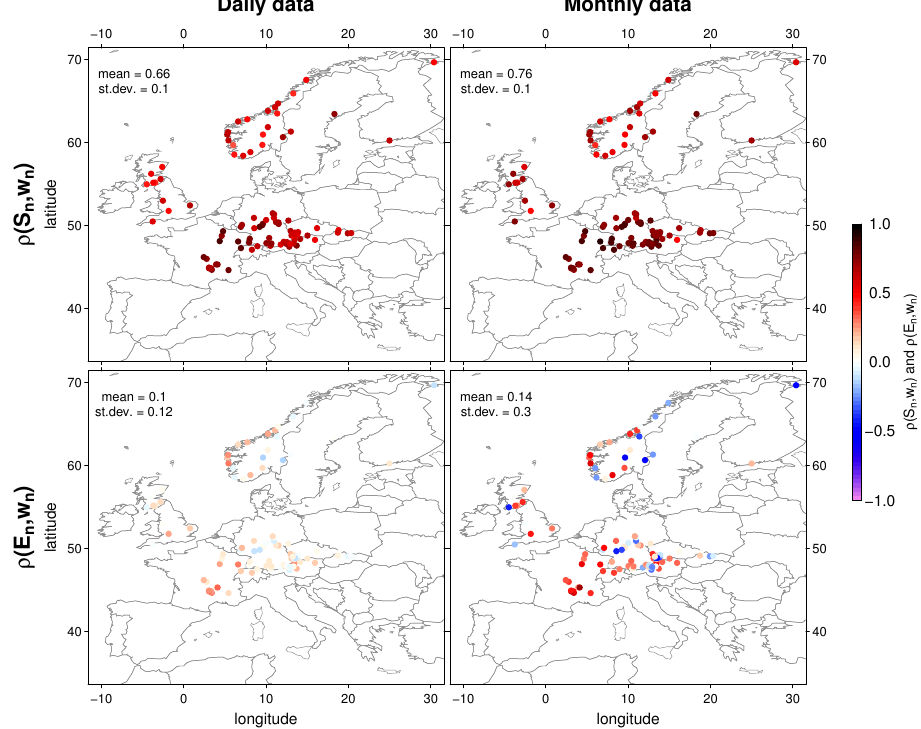
Fig. 8. Geographical distribution of mean May–September soil moisture-streamflow (upper row) and soil moisture-ET (lower row) coupling strengths ρ (Q n ,w n ) and ρ (E n ,w n ) , respectively, for daily and monthly averaged data. Respective strengths are shown through the colour coding. In the upper left corner of each plot the mean and standard deviation over the selected catchments are displayed.